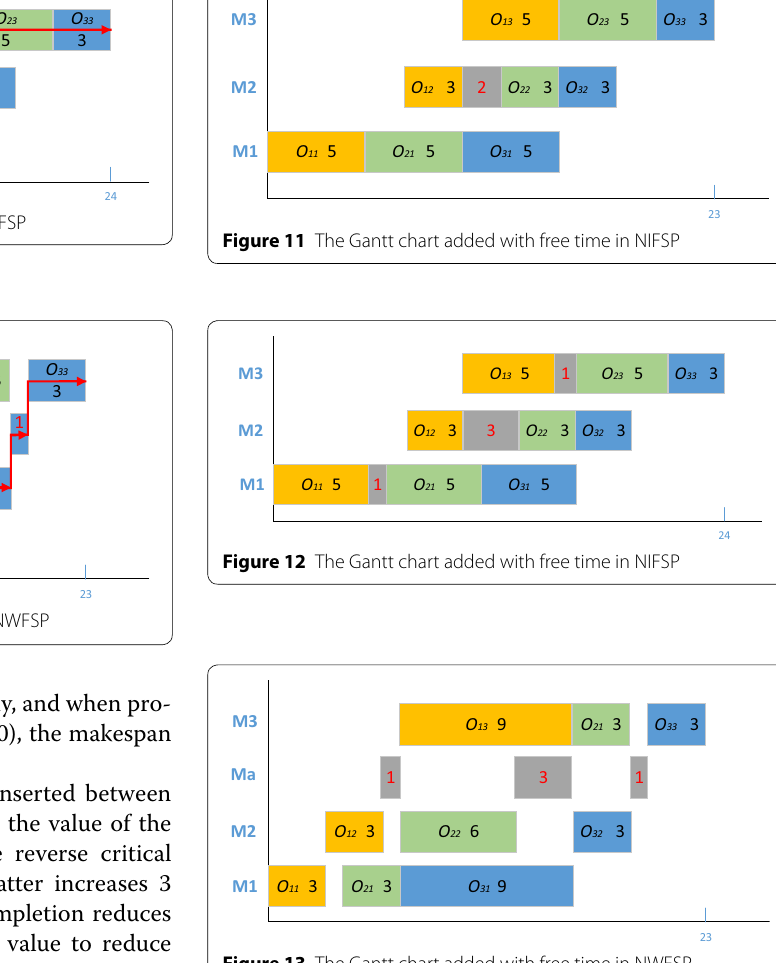
grey blocks represent the waiting time of the operation, and it is easy to know that it has the same effect as the anomalies.